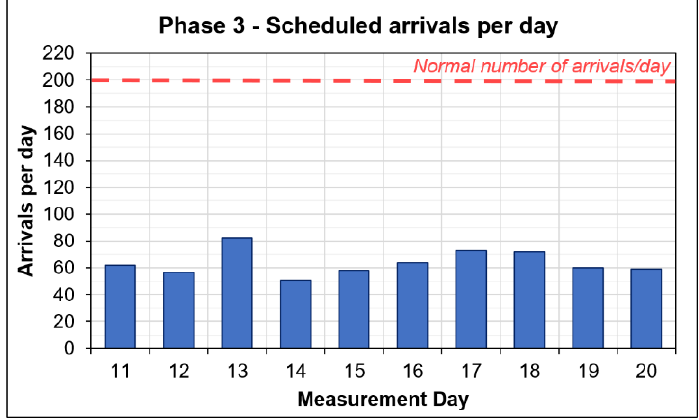
Figure 2. Comparison of daily arrivals to those before the COVID-19 pandemic.